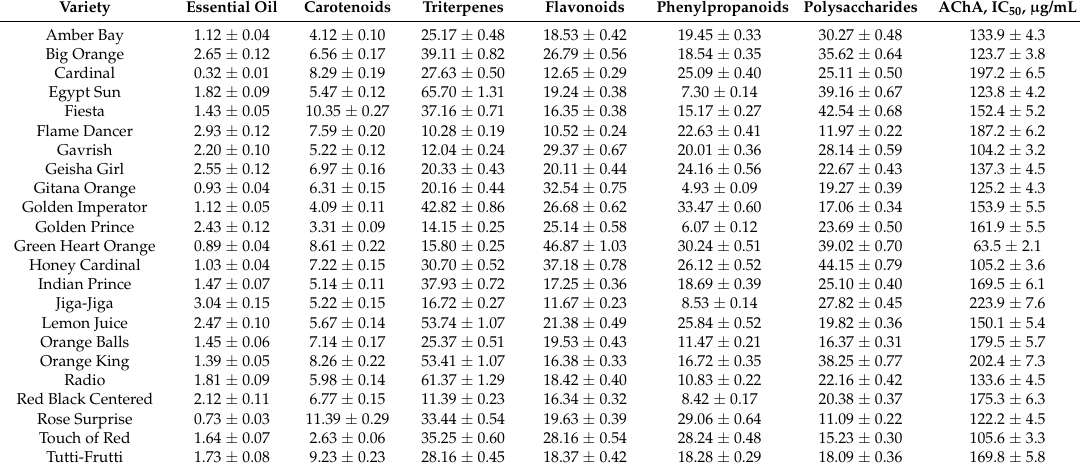
Table 1. Chemical composition and anti-acetylcholinesterase activity (AChA) of total extracts of 23 varieties of C. officinalis flowers (mg/g dry weight (DW) ± standard deviation (SD)) 1 .